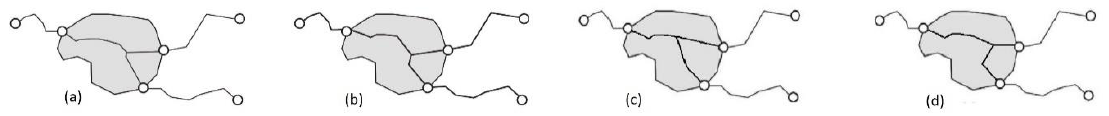
Figure 7. Skeletons of the same polygon generated with the ( a ) straight skeleton method [6]; ( b ) Splitarea algorithm [10]; ( c , d ) BPSplit algorithm and skeleton adjustment.